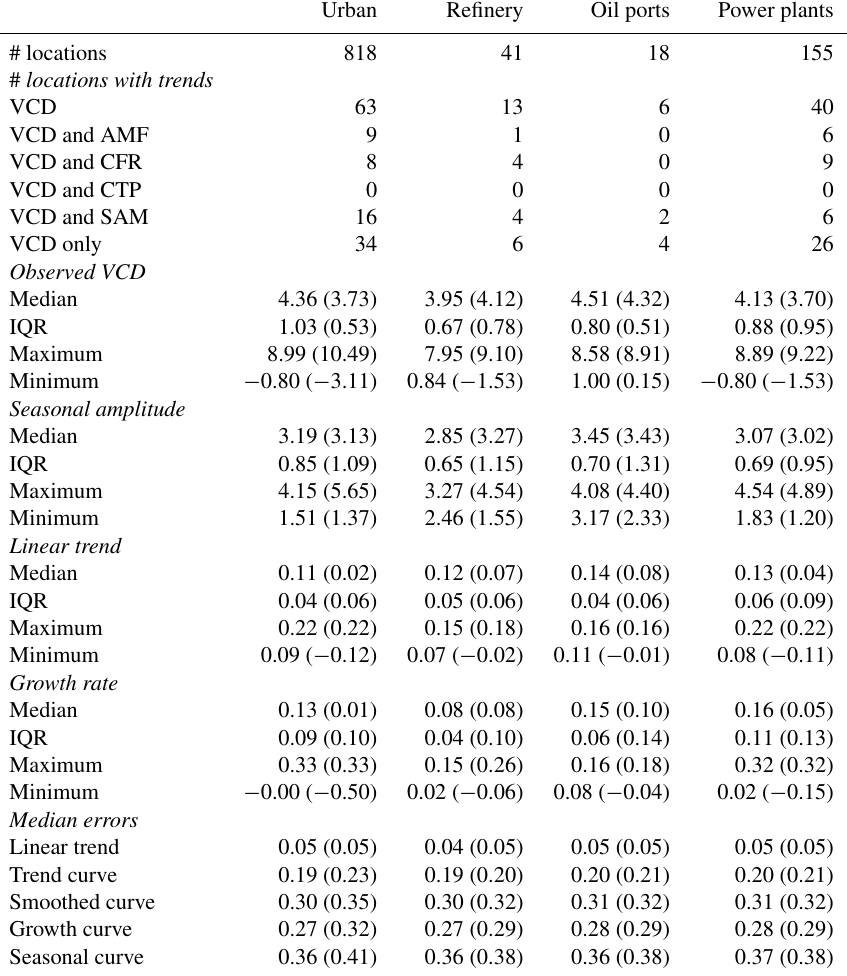
Table 2. Statistical summary of the SAO HCHO vertical column density (VCD) analysis conducted at an approximate 10 km radius over the target locations. Statistical values are shown for those locations which have a real VCD trend, i.e. those locations without a corresponding trend in either the air mass factor (AMF), cloud fraction (CFR), cloud-top pressure (CTP), or number of samples (SAM). Values in parenthe- ses correspond to statistics for all locations of a given category. VCD values are given in 10 15 moleculescm − 2 , and IQR is the interquartile